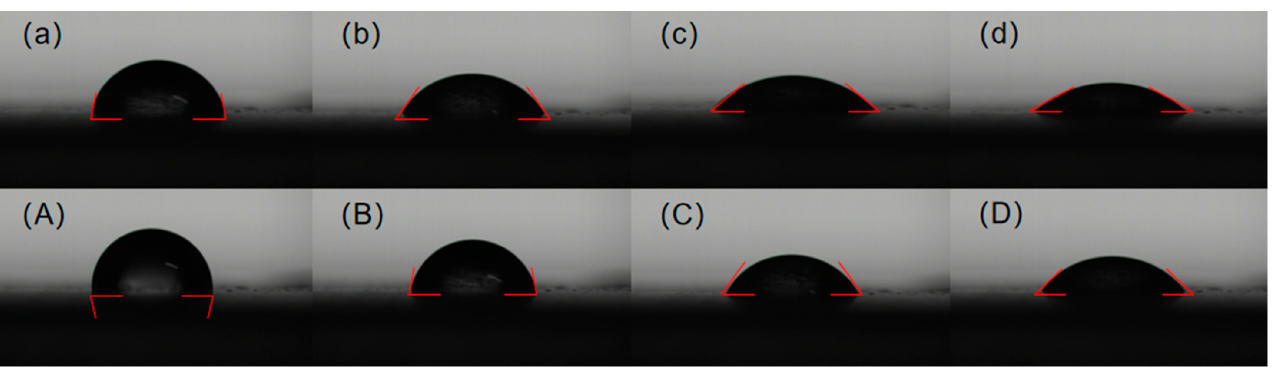
Figure 8. Contact angle images of 0.2 mmol/L DCB (a, b, c, d) and DSB (A, B, C, D) solutions on para ffi n surface at di ff erent times: ( a ) 0 min, 75.60°; ( b ) 2 min, 50.33°; ( c ) 10 min, 32.78°; ( d ) 20 min, 28.36° for DCB and ( A ) 0 min, 95.60°; ( B ) 2 min, 70.33°; ( C ) 10 min, 42.78°; ( D ) 20 min, 35.26° for DSB.